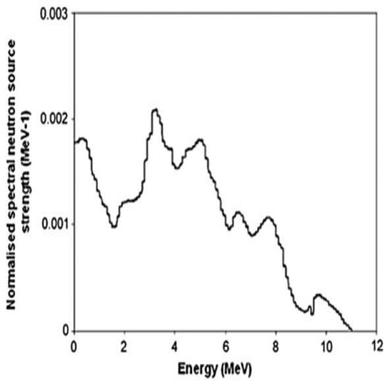
Am–Be neutron source spectrum.